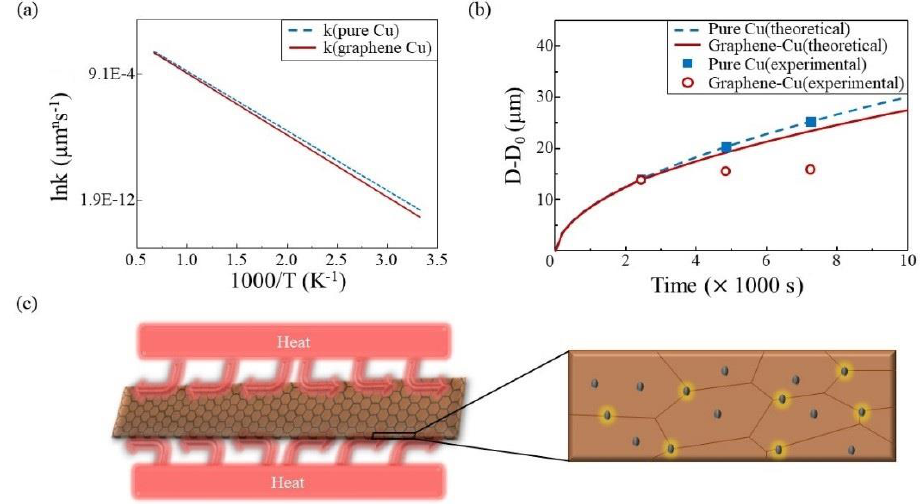
Figure 5. Pure Cu foil and graphene-covered Cu foil. ( a ) Plot of ln k against the annealing temperature (1000/ T ), ( b ) ( D − D 0 ) against time, ( c ) schematic representation of the reasons of the gap between experimental and theoretical values for the graphene-covered Cu in ( b